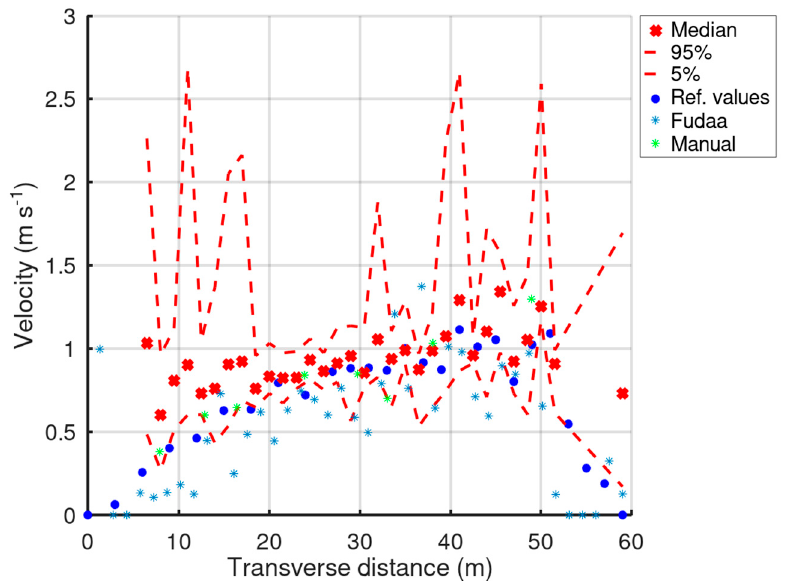
Figure 10. Salmon River. Free-LSPIV 90% confidence interval and median values, the reference values, the surface velocities obtained with Fudaa-LSPIV, and the surface velocities estimated manually.